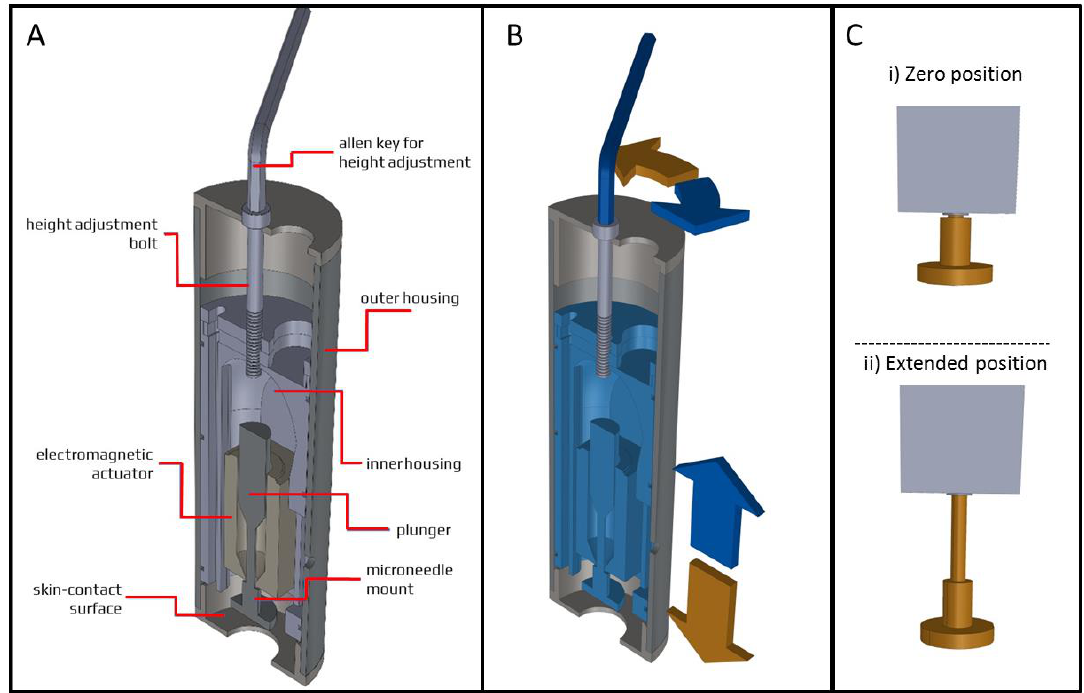
Figure 2. Design of the applicator ( A ) of which the inner housing (including the microneedle mount onto which microneedle arrays (MNAs) can be attached) can move towards the skin-contact surface by turning an allen key counterclockwise (brown arrows) and moving upwards by turning the allen key clockwise (blue arrows) ( B ). The electromagnetic actuator moving the microneedle mount ( C ).